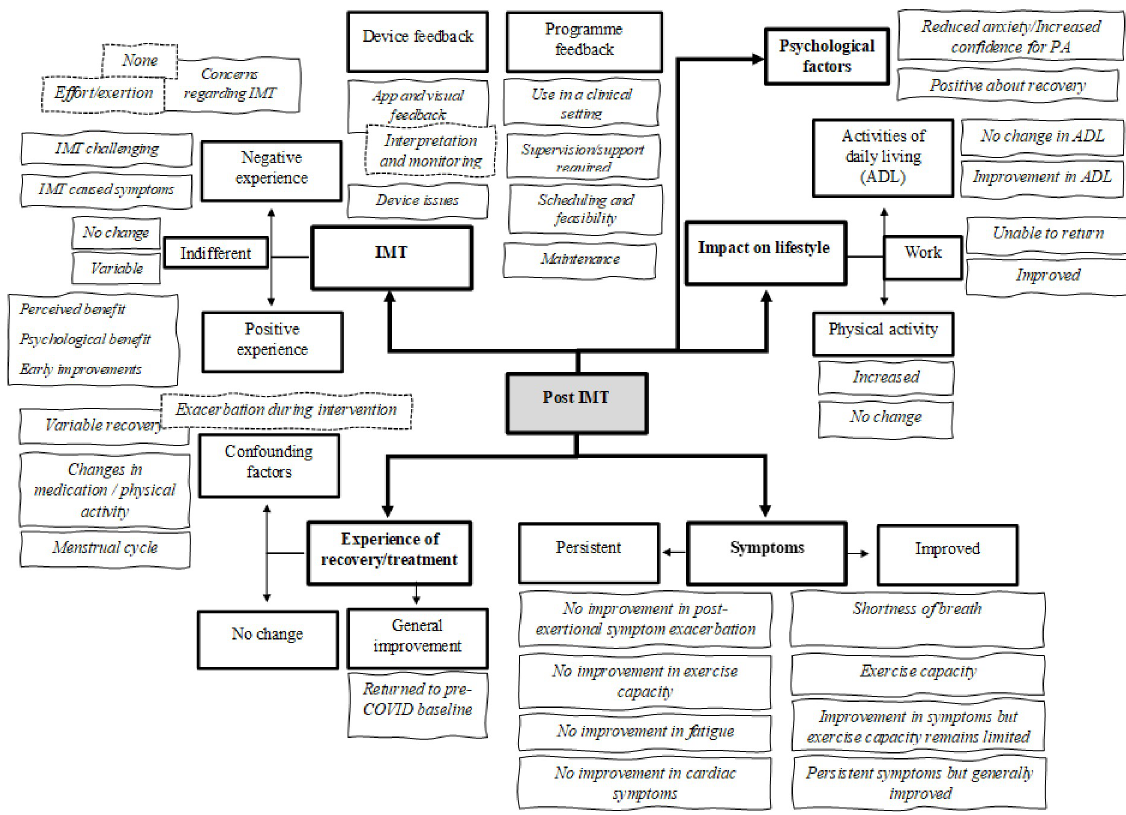
Fig 1. The five overarching themes (bold text and box), sub-themes (standard font and bold box), codes (italic text) and related codes (italic text and dashed box) identified from semi-structured interviews exploring individuals’ experiences of COVID-19 recovery following an 8-week inspiratory muscle training intervention (IMT = Inspiratory Muscle training; COVID-19 = Coronavirus disease- 2019; PA = Physical Activity; ADL = Activities of Daily Living).